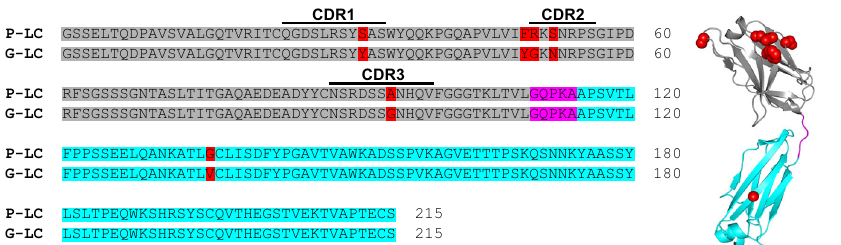
Fig. 1 Sequence alignment and homology model of FOR005. The V L domain is colored in gray, the linker region in magenta, and the C L domain in cyan. Mutations are indicated in red. The homology model was created with SWISS-MODEL using template structure 5BV7. The C-terminal cysteine at position 214 has been mutated to serine in all constructs to result in monomeric proteins.